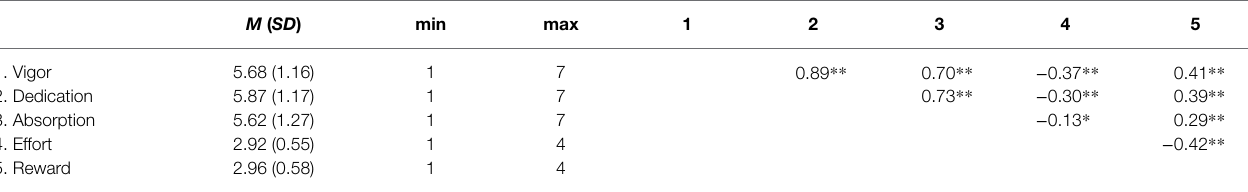
TABLE 1 | Descriptive statistics and correlation matrix for the criterion variables upon which the latent profile analysis was based. M ( SD ) min max